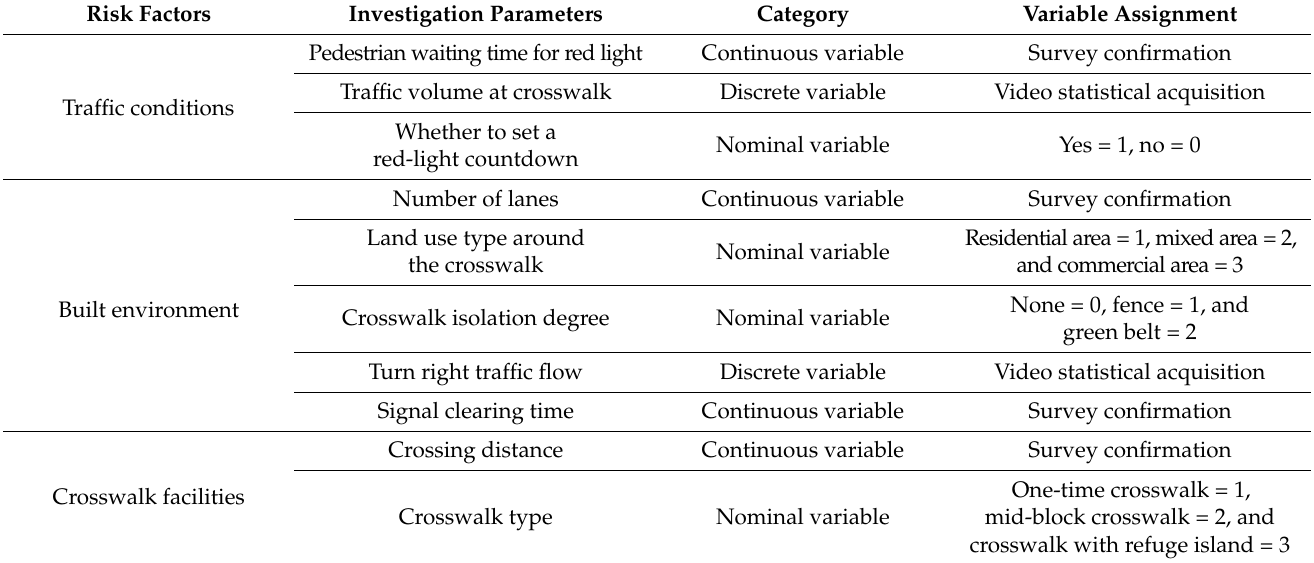
Table 1. Variable assignment of risk